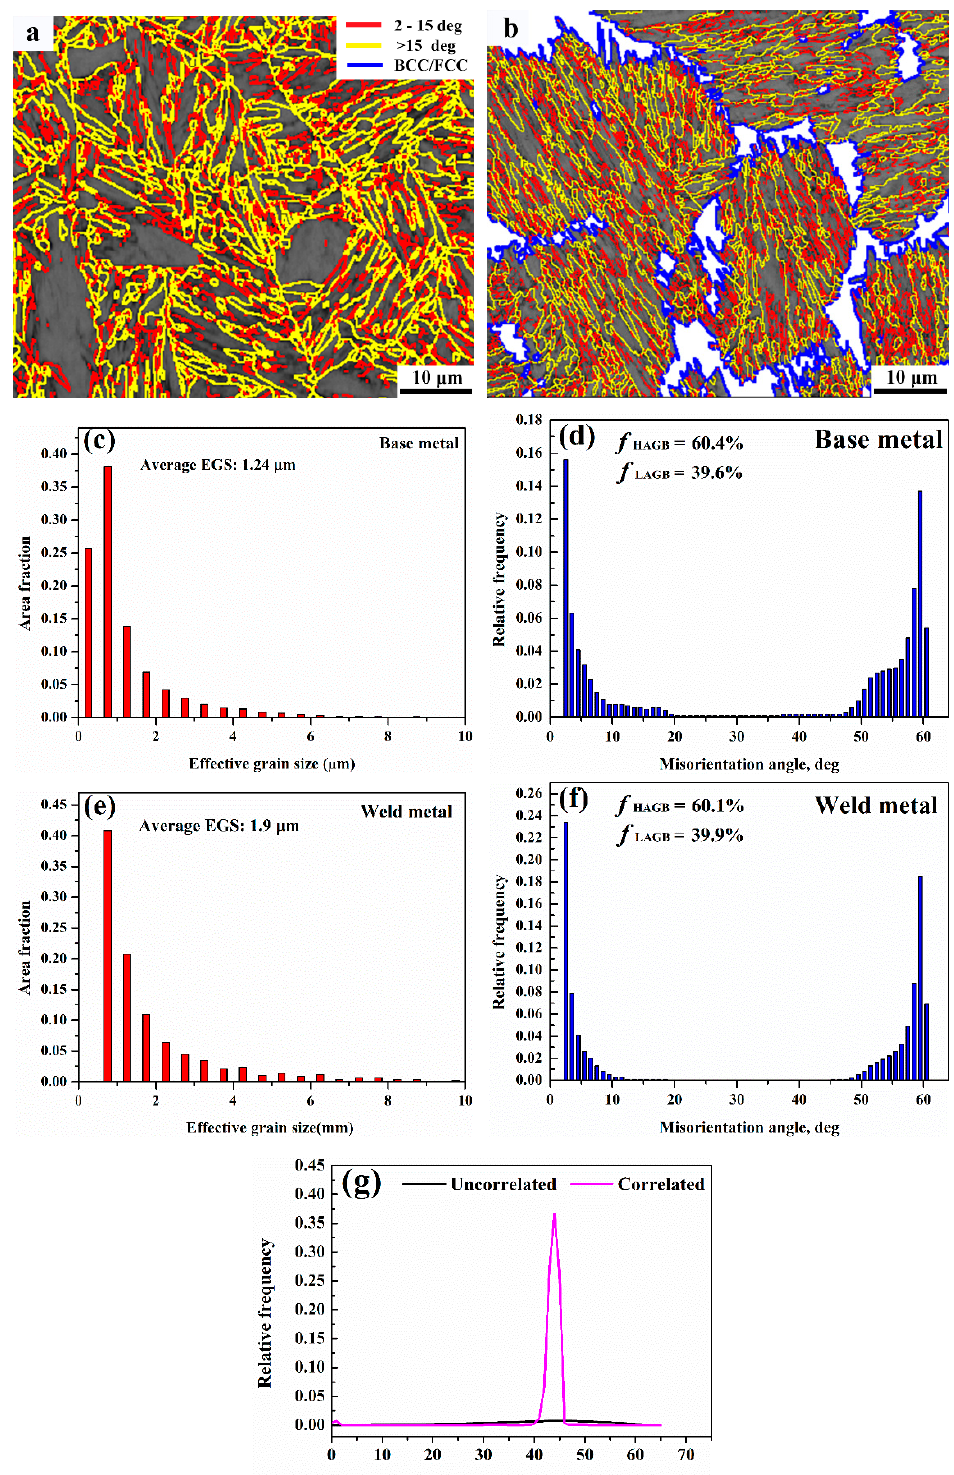
Figure 9. Statistics of effective grain size and misorientation angle; ( a ) and ( b ) Misorientation distribution maps superimposed on band contrast map in a BCC structure for base metal and weld metal, respectively; ( c ) and ( d ) Effective grain size for base metal and weld metal respectively; ( e ) and ( f ) Misorientation angle distribution for base metal and weld metal, respectively; ( g ) Misorientation angle distribution between martensite and austenite in the weld metal.